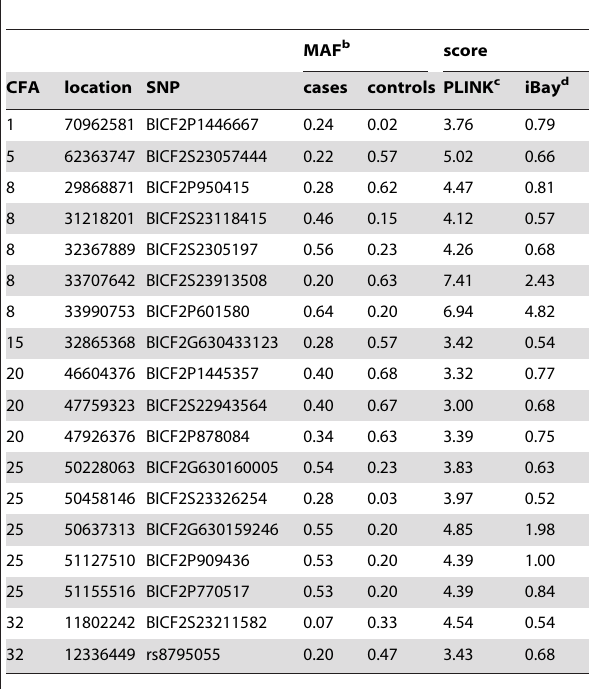
Table 1. Array SNPs associated with hip dysplasia in Labrador Retrievers a